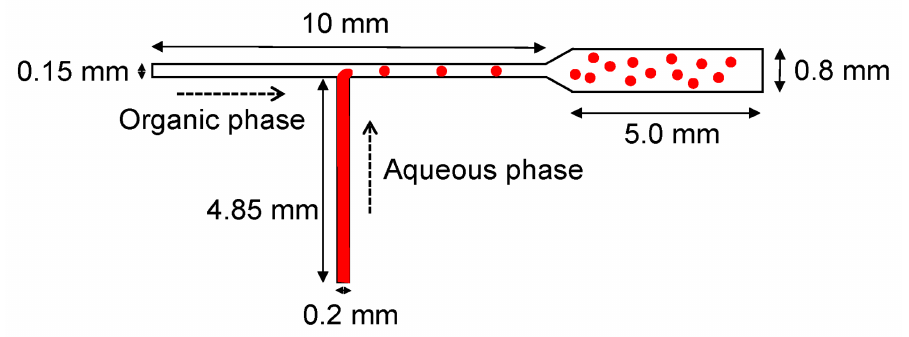
Figure 1. Schematic illustration of microdroplet formation in a T-shaped microfluidic channel. Reprinted from an open-access source